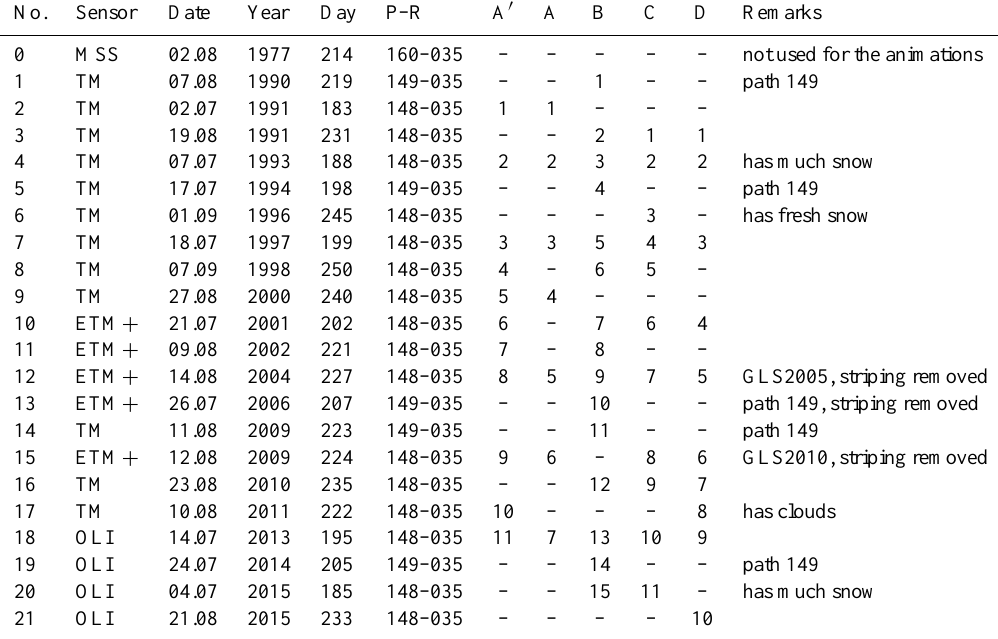
Table 1. Overview of the 21 Landsat scenes used to create the animations in the Supplement for the four subregions shown in Figs. 2–5. The MSS scene is only added for completeness. Abbreviations are as follows. From the “sensor” column, MSS: MultiSpectral Scanner, TM: Thematic Mapper, ETM + : Enhanced Thematic Mapper + and OLI: Operational Land Imager. “Date” shows day.month, “day” signifies the day number within a year and “P–R” shows path–row. Letters in columns 7–11 denote the following subregions: A (cid:48) and A: Baltoro, B: Panmah, C: Skamri, D: Shaksgam. The number in each column, A to D, gives the order in the sequence. GLS: Global Land Survey. Note that for the animation in the Supplement, only the subset A is used; an extended time-series A (cid:48) can be created from the individual images available from